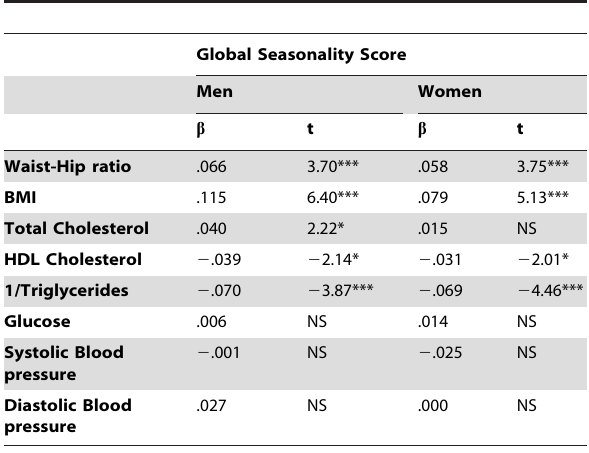
Table 2. The impact of the Global Seasonality Score on objective health risk factors.